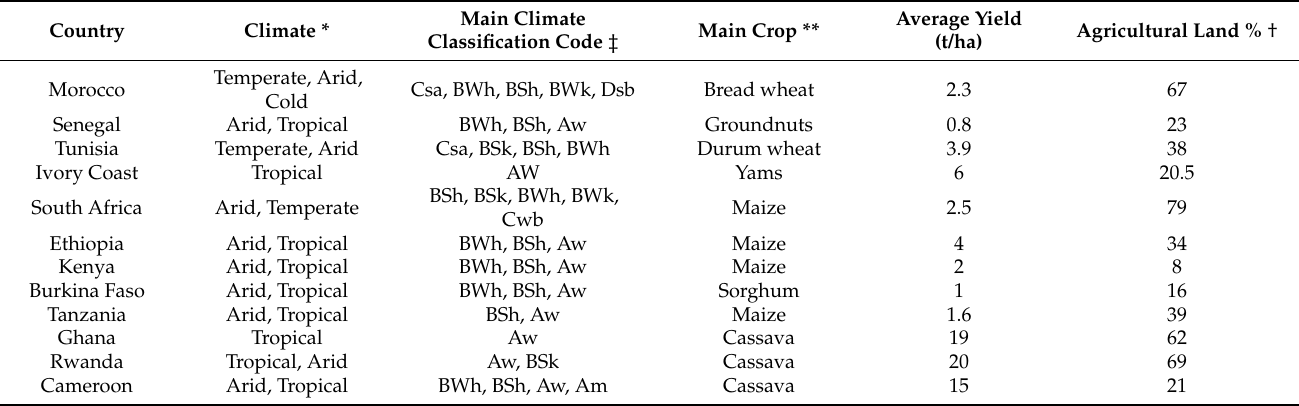
Table 1. The table shows the climate of 13 African countries, along with the main crop, average yield, and the percentage of agricultural land related to the country’s total area.